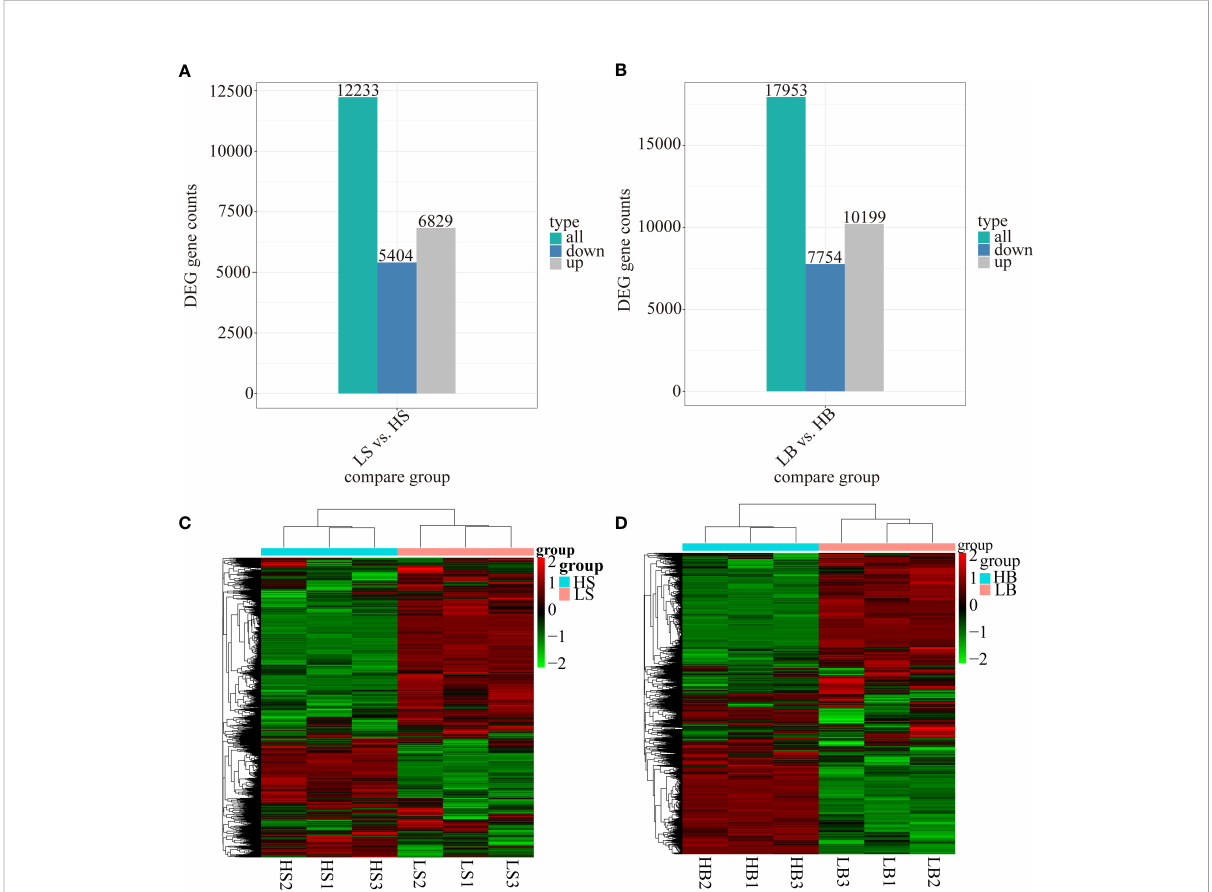
FIGURE 5 Identi fi cation and analysis of the differentially expressed genes of H. ammodendron and H. persicum . (A, B) are the numbers of H. ammodendron and H. persicum DEGs in humid and arid environments. (C, D) show the hierarchical clustering of DEGs of all samples of H. ammodendron and H. persicum